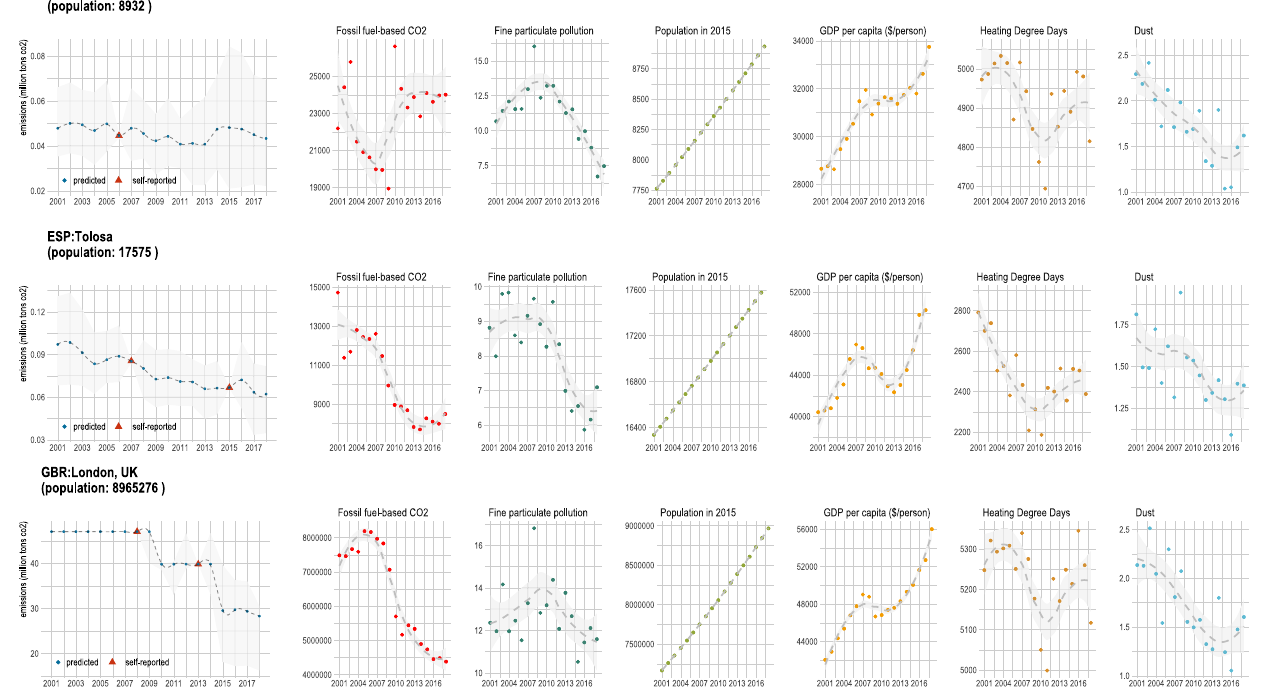
Fig. 3 | Predicted, self-reported emissions, and primary predictor variables for three cities of varying population sizes. Waimes in Belgium, Tolosa in Spain, and London in the United Kingdom were selected to represent cities of varying population sizes.